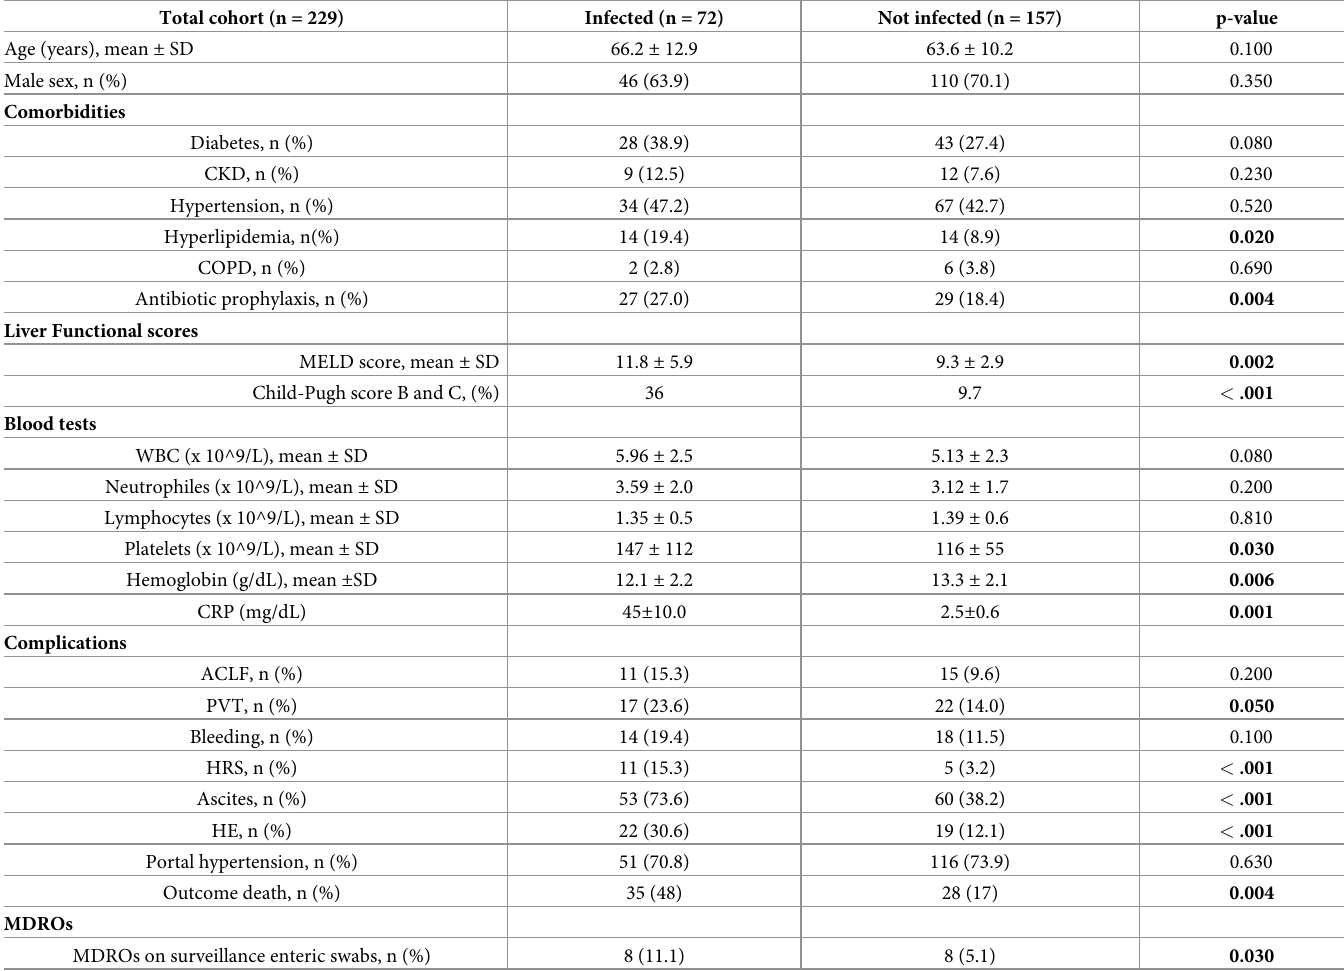
Table 2. Baseline characteristics in not infected and infected